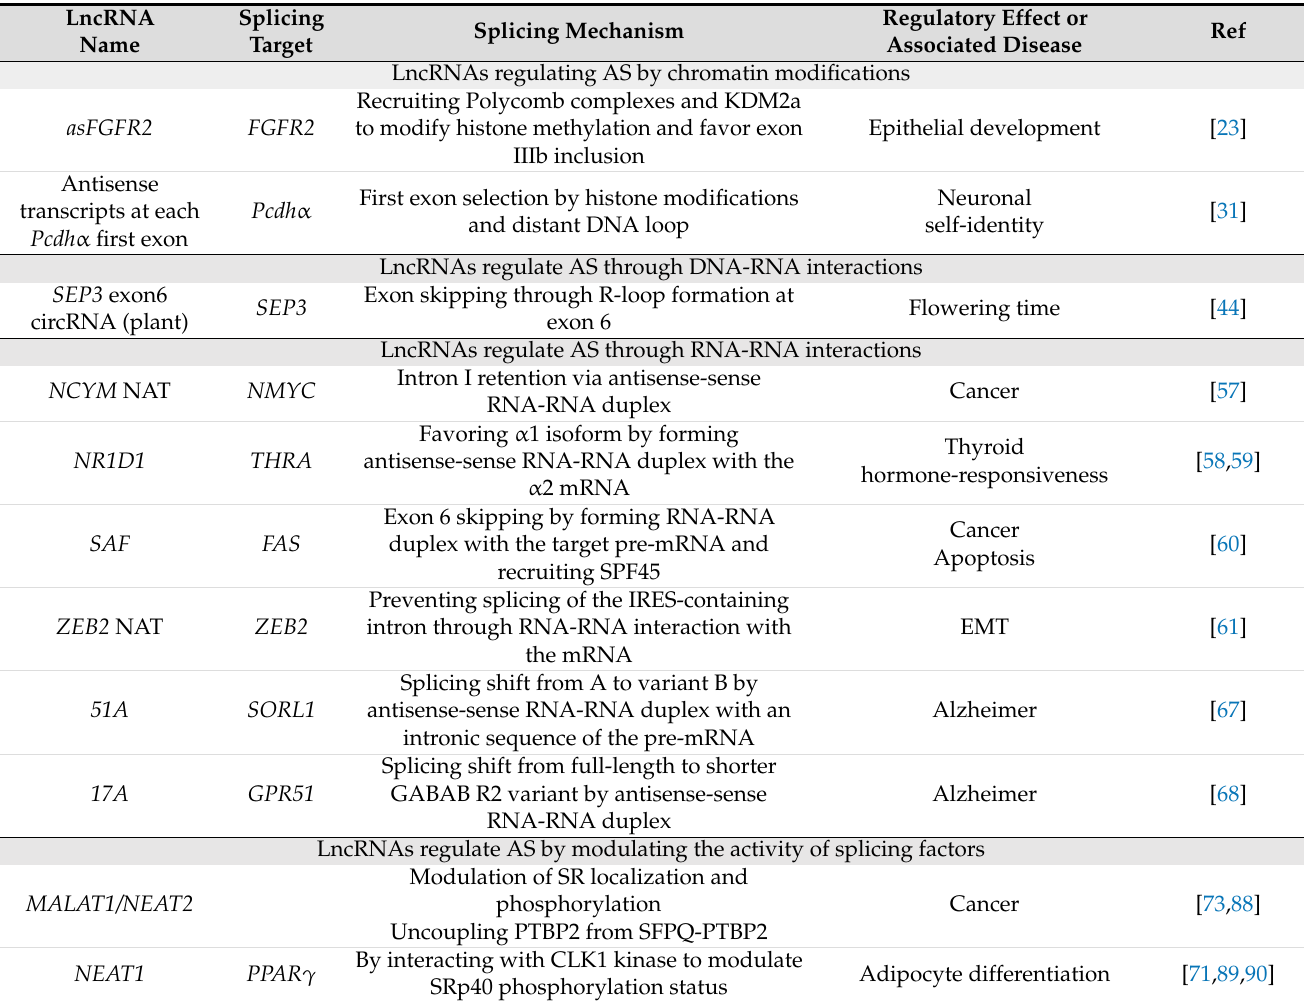
Table 1. List of lncRNAs involved in splicing